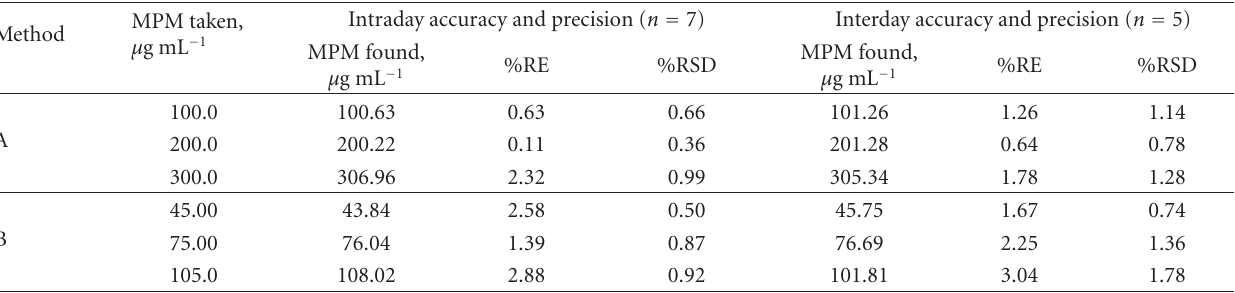
Table 2: Evaluation of intraday and interday accuracy and precision.